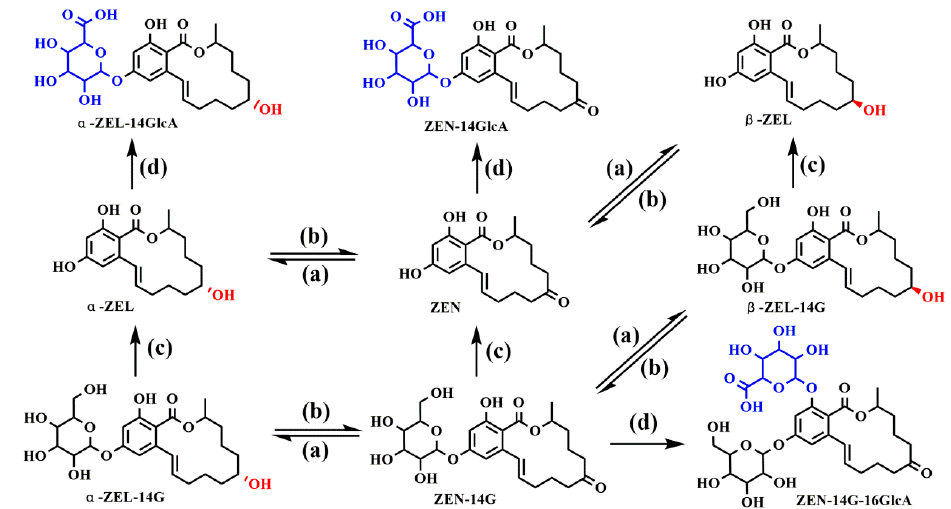
Figure 2. The chemical structures of ZEN-14G metabolites observed in plasma, and their proposed metabolic pathways after oral and intravenous injection (i.v.) administration, including ( a ) hydrogenation, ( b ) dehydrogenation, ( c ) deglycosylation, and ( d ) glucuronidation.